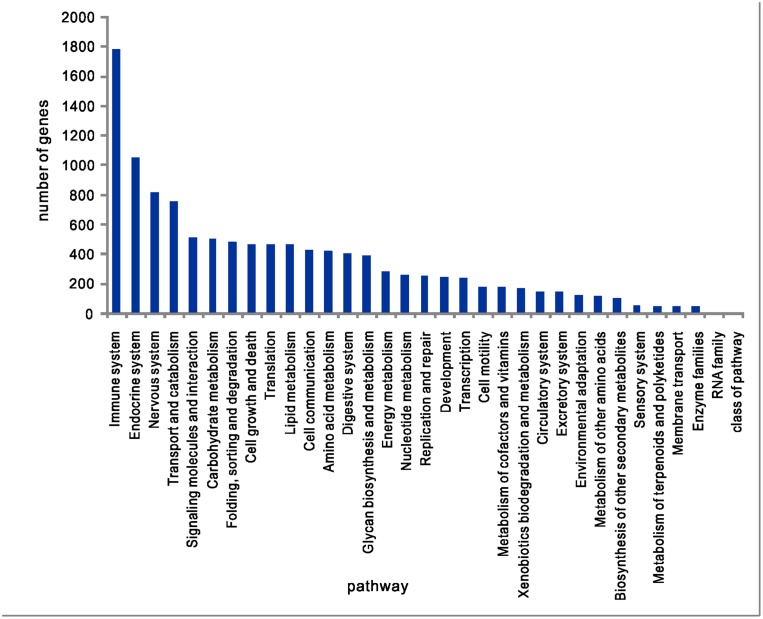
KEGG classification.